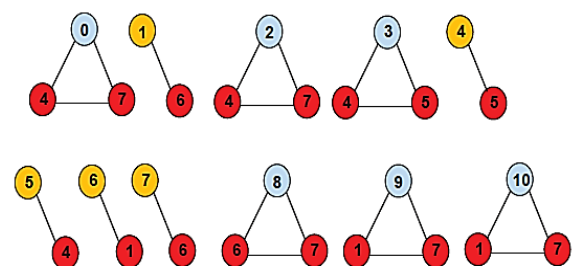
Figure 2. Controller-switch assignments for the Sprint